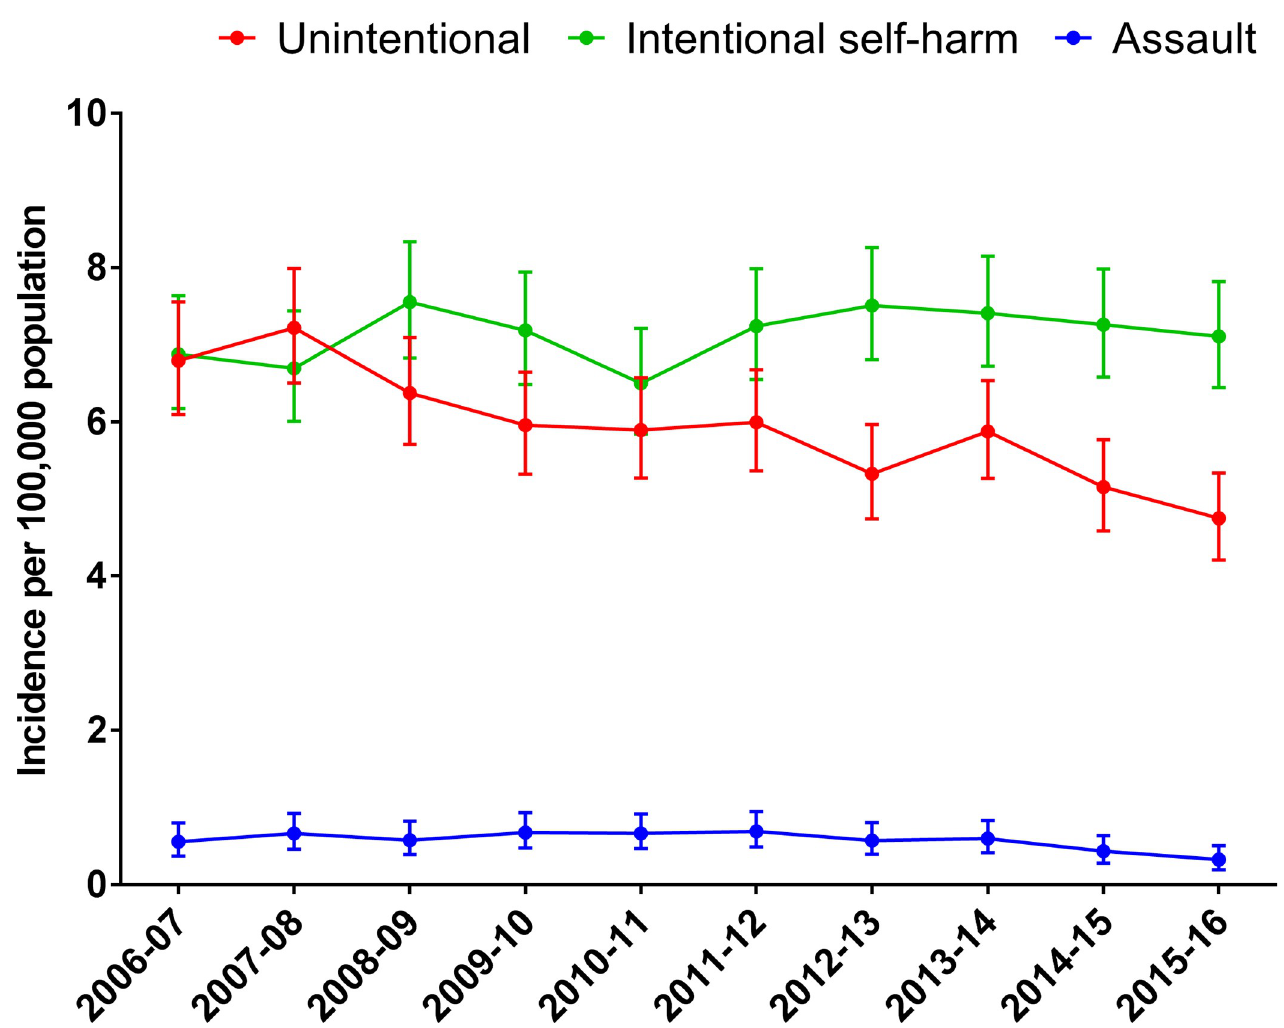
Fig 3. Incidence of out-of-hospital trauma deaths by the intent of the